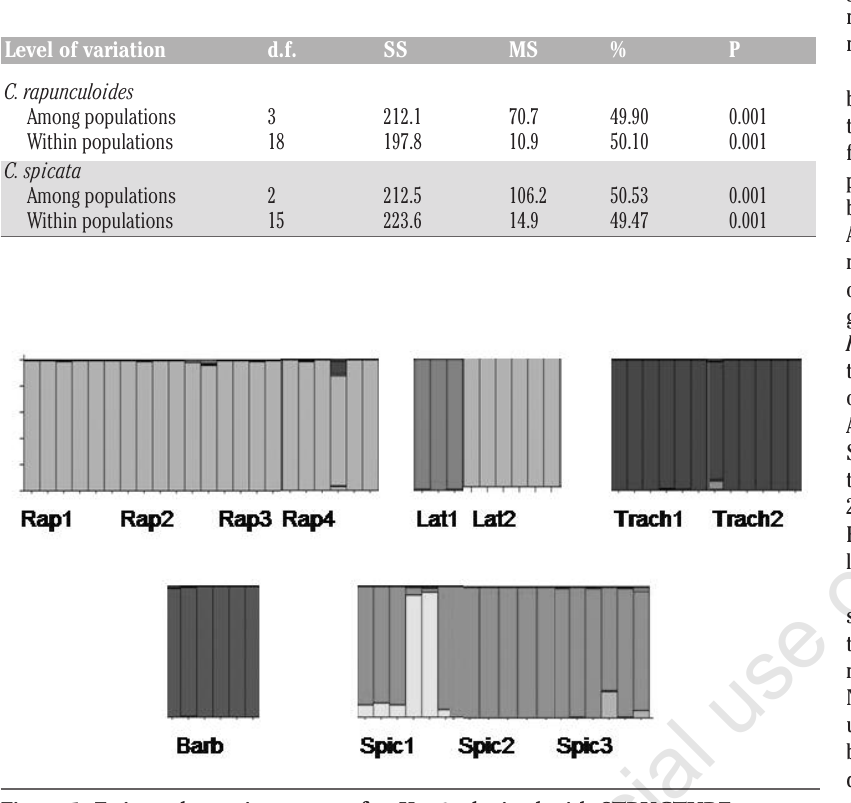
Figure 5. Estimated genetic structure for K = 9 obtained with STRUCTURE program from myb and NBS data sets. Each individual is represented by a vertical bar, which is partitioned into different colored segments that represent the individual’s estimated mem- bership fractions in nine